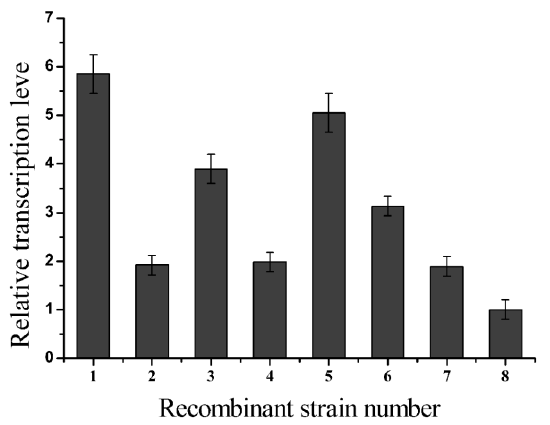
Figure 1. Comparison of the Mglu gene transcriptional levels of the transformants with Mglu integrated into the 16S rDNA gene of B. subtilis . Transcriptional levels were measured using the 2 − ∆ tt assay. The transcriptional level of strain No. 8 was defined as 100%. The standard errors are calculated from three independent biological experiments.